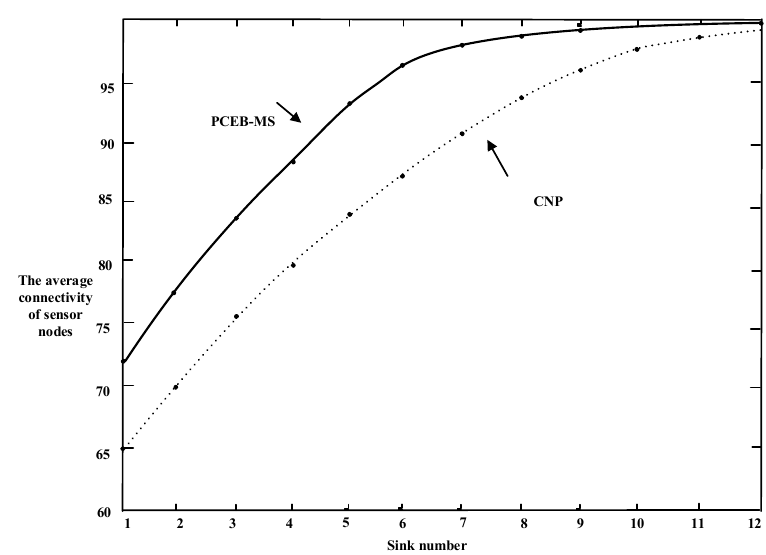
Figure 10. Comparison of average connectivity.